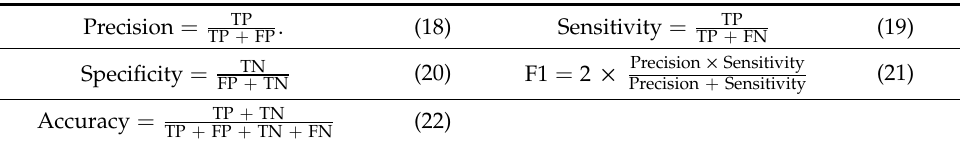
Table 4. Performance evaluation Table 4 . Performance evaluation parameters.